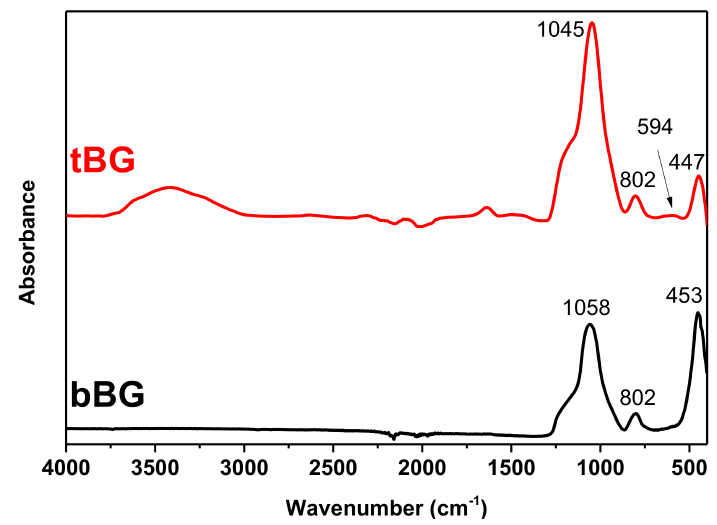
Figure 2. FTIR spectra of bBG and tBG.